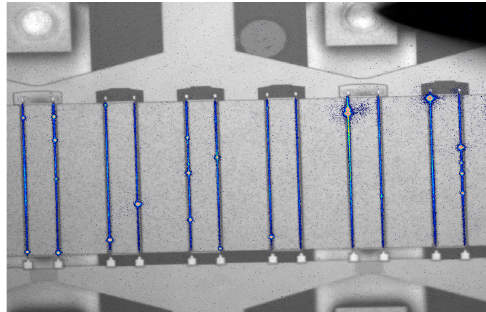
Fig. 6. PE signature of a fresh device in transistor mode: (Vgs , Vds)=(-7V,